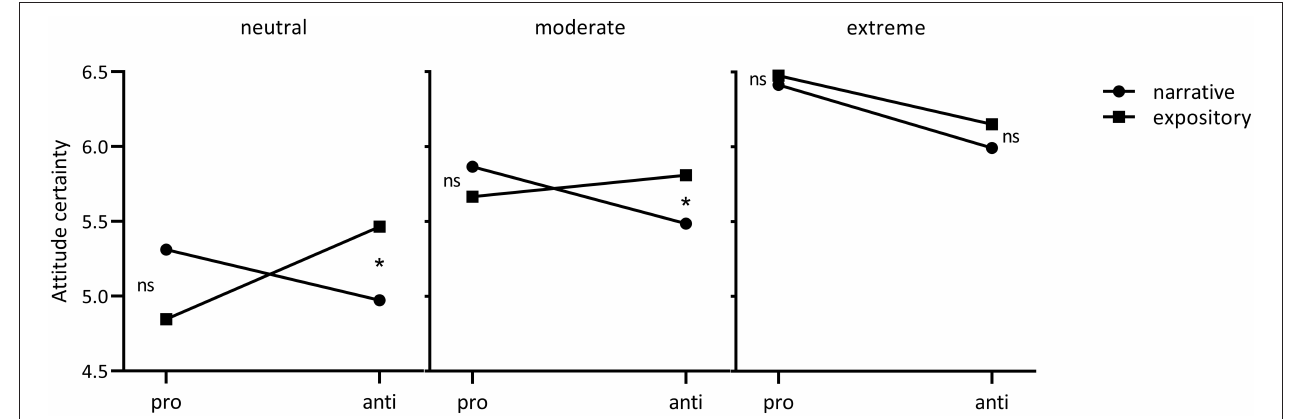
FIGURE 3 | Exploratory format*content*vaccination attitude interaction on attitude certainty. The three panels reflect the extent to which participants reported a positive attitude toward vaccination, labeled “neutral” ( M – 1 SD ), “moderate” ( M ), “extreme” ( M + 1 SD